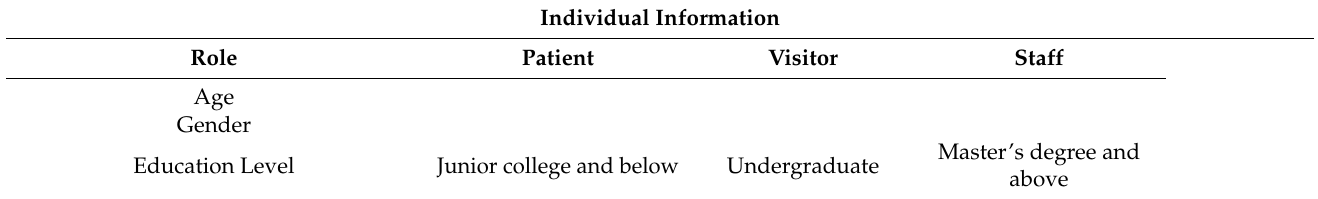
Table A2. Questionnaire for Respondents’ Expectations and Satisfaction of the Functional Settings of the Outdoor Space at the Southwest